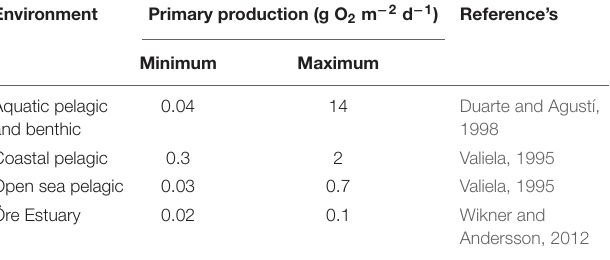
TABLE 1 | Comparison of the range of primary production in the studied oligotrophic estuary, the data set of Duarte and Agustí (1998) and other global compilations from dominant marine